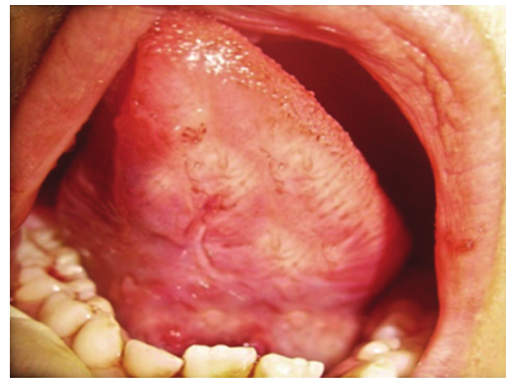
F 8: Postoperative photograph aer 1 year (Case 2).